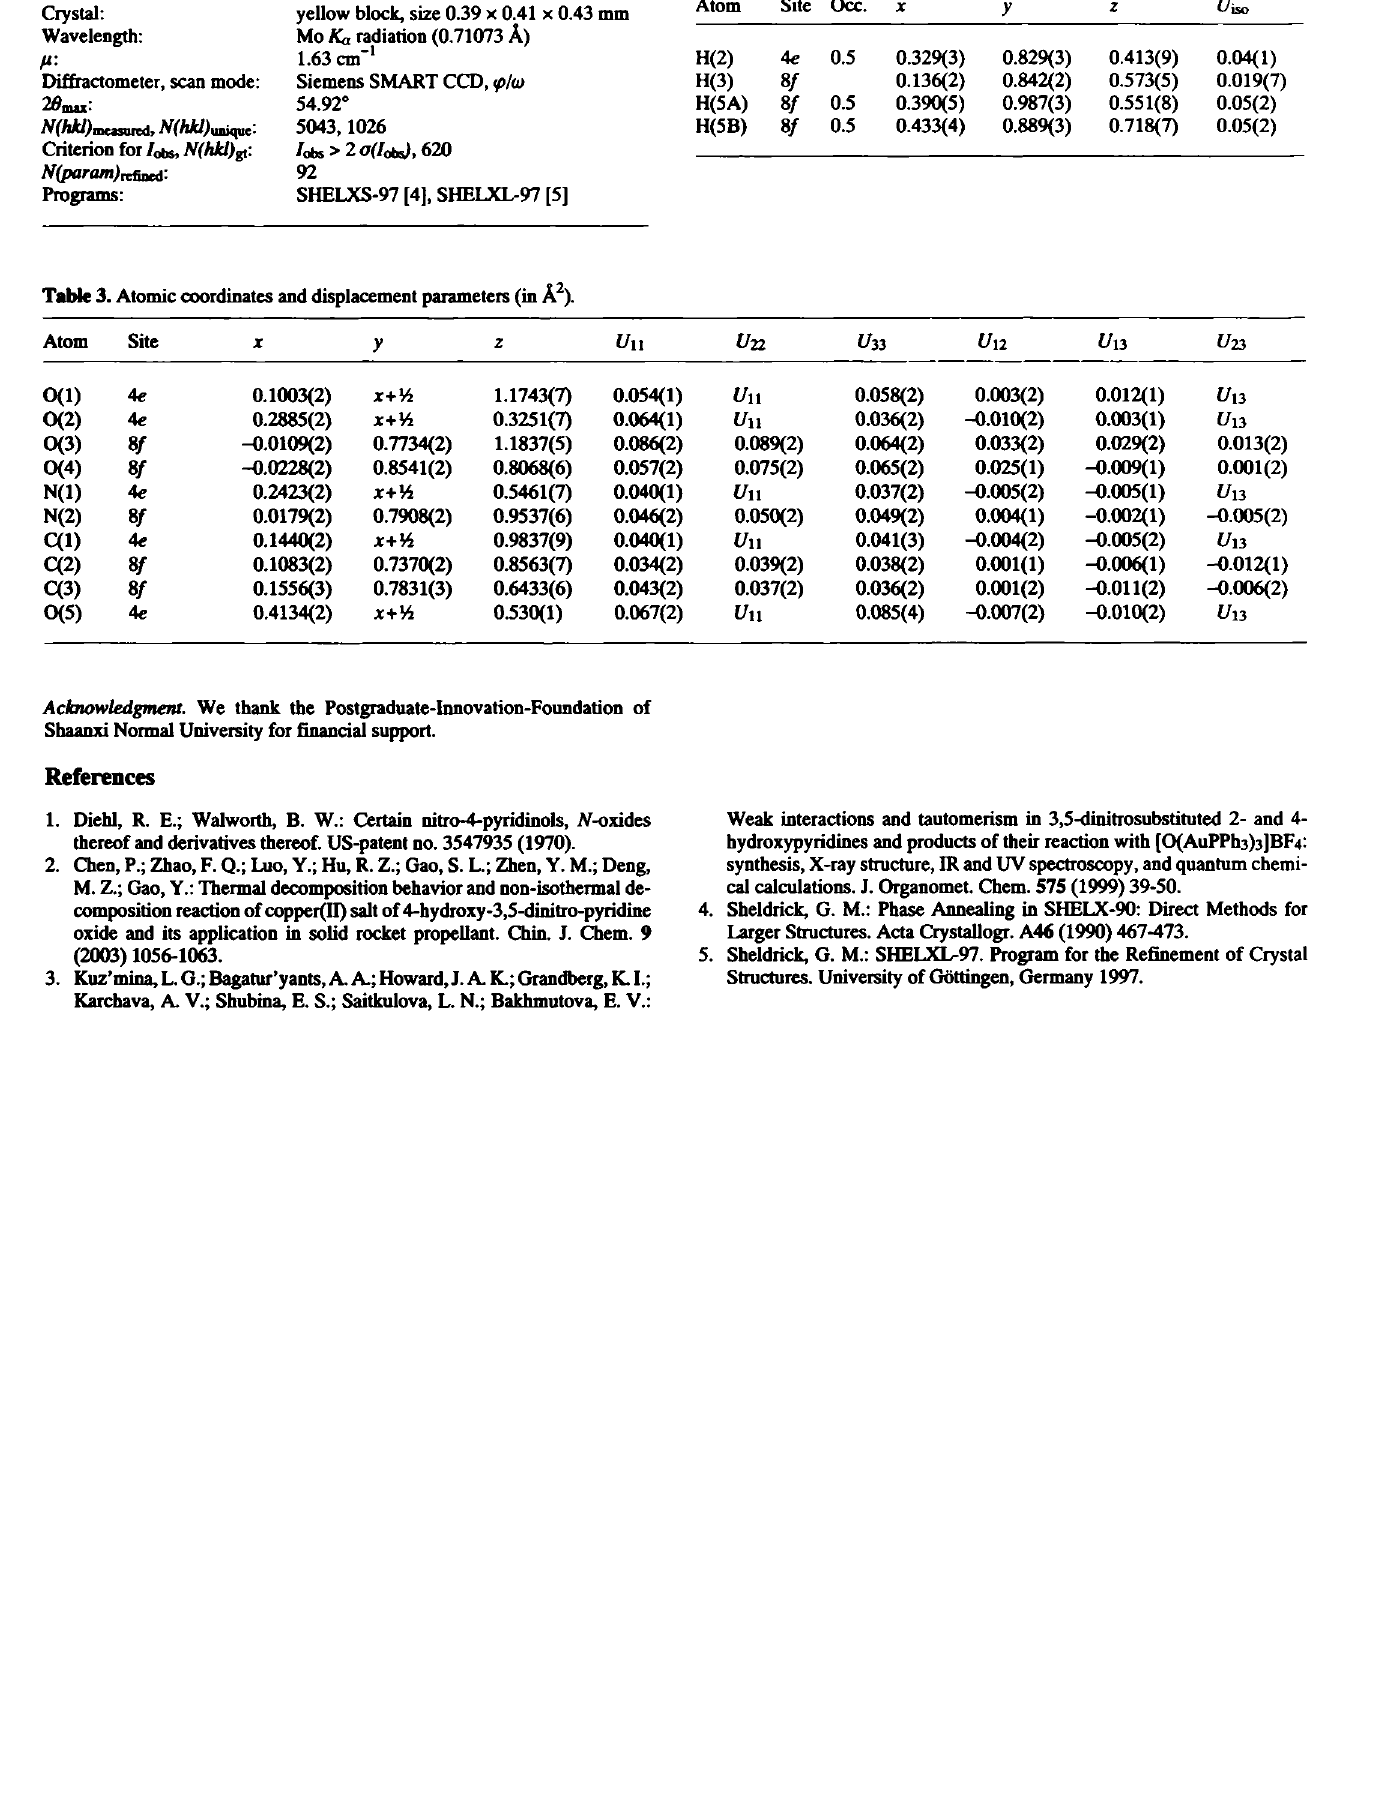
Table 3. Atomic coordinates and displacement parameters (in Ä 2